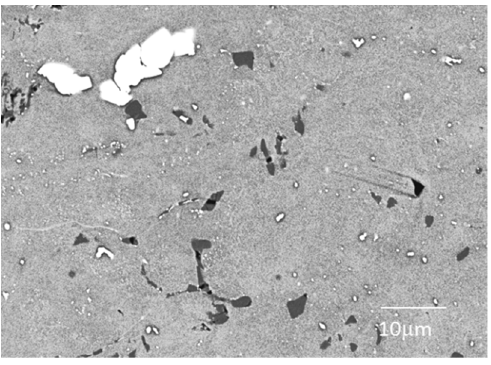
Figure 1. DSC curve of as-homogenized Ti 50 Ni 49 W 1 alloy. M *: The martensite peak temperature. A *: The austenite peak temperature.